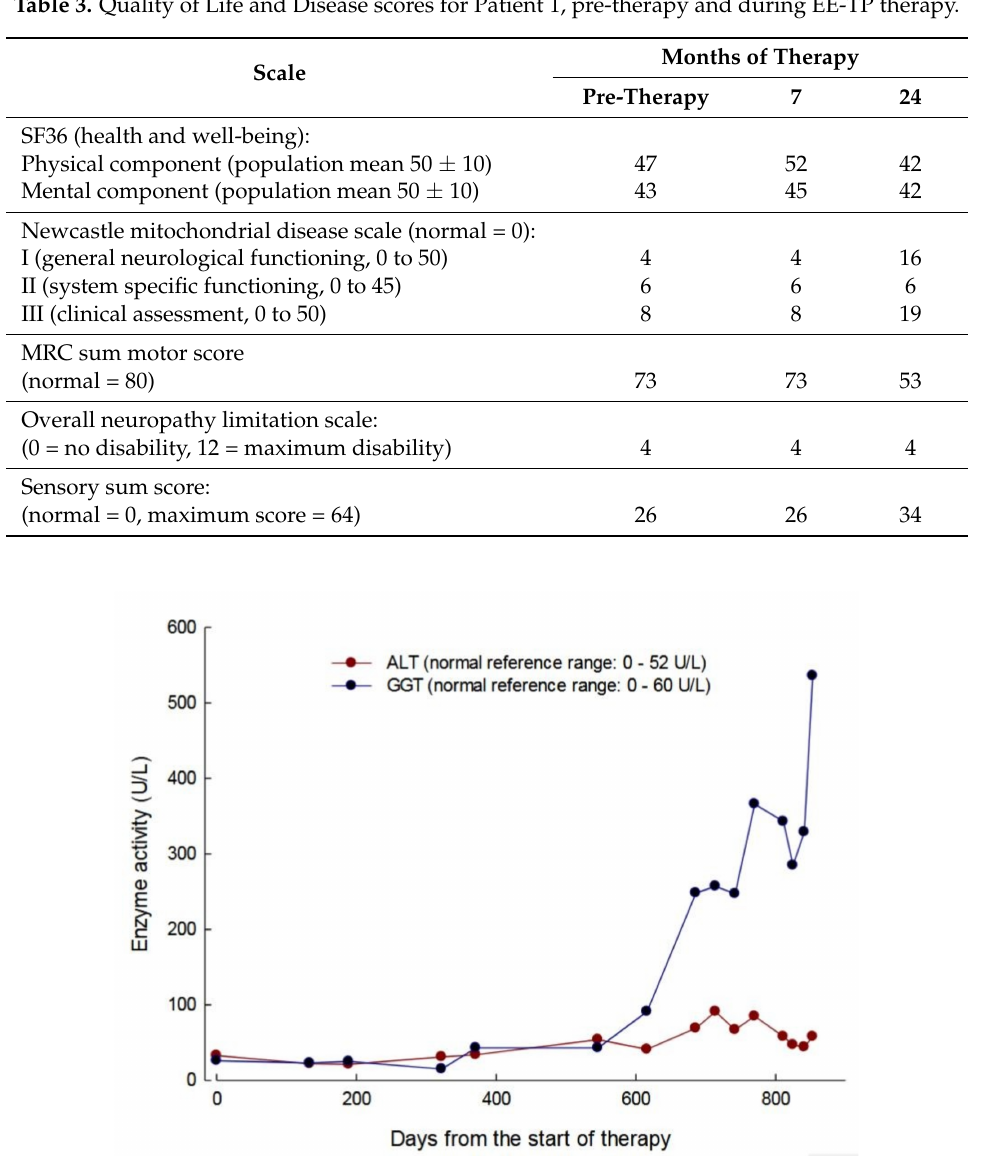
Figure 5. Serum alanine minotransferase (ALT) and gamma-glutamyl transpeptidase (GGT) activities in patient 1 during 31 treatment cycles of EE-TP administered over 28 months. The blue symbols represent GGT and red symbols